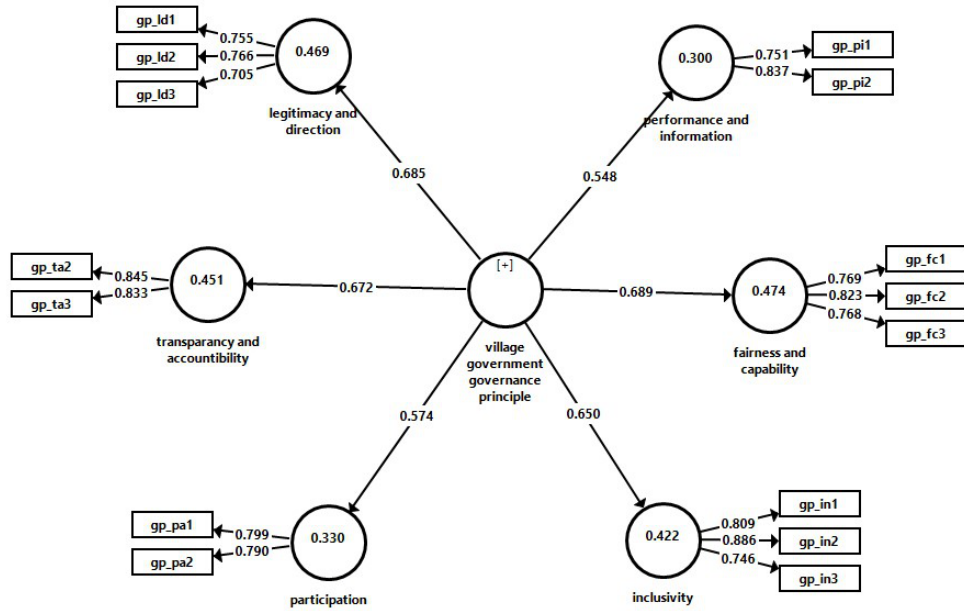
Figure 2. Measurement model.